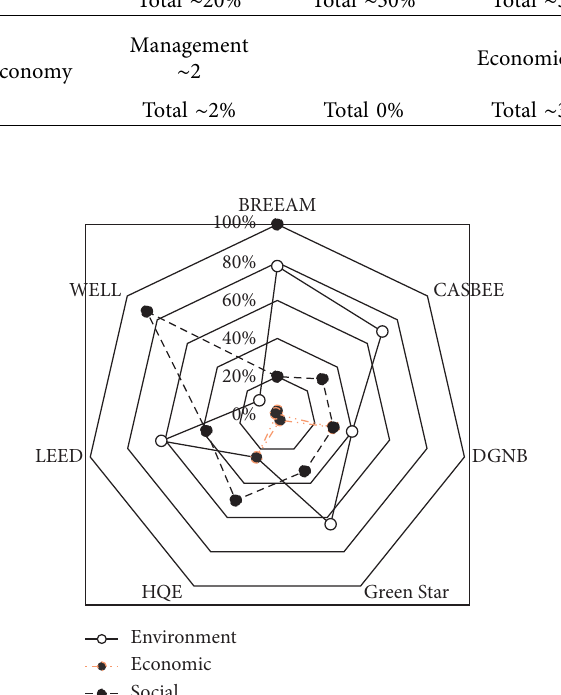
Figure 2: Distribution of sustainable aspects among BEA